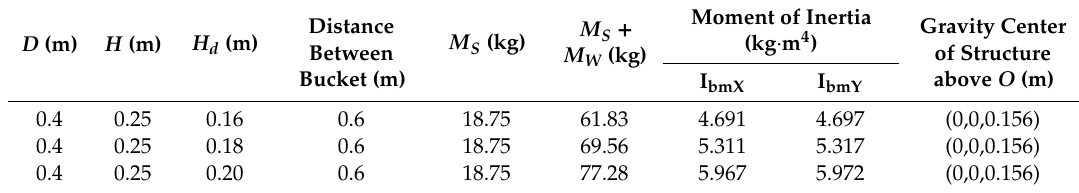
Table 1. Pertinent parameters of the physical model in the experiments.